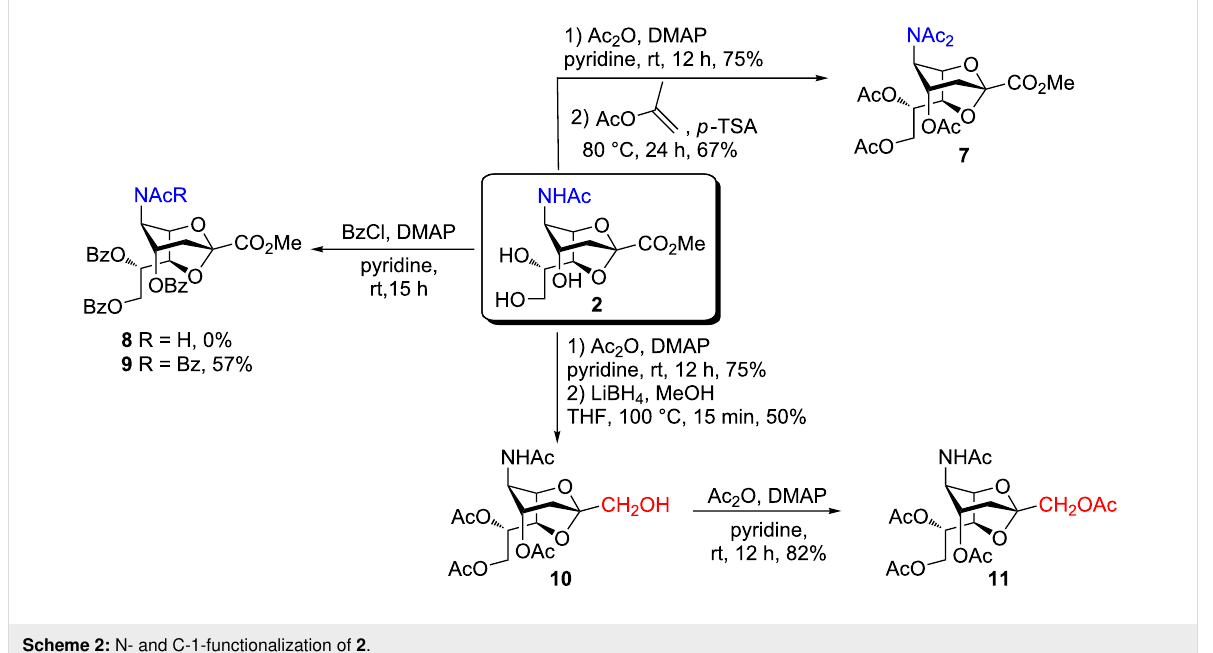
Scheme 2: N- and C-1-functionalization of 2